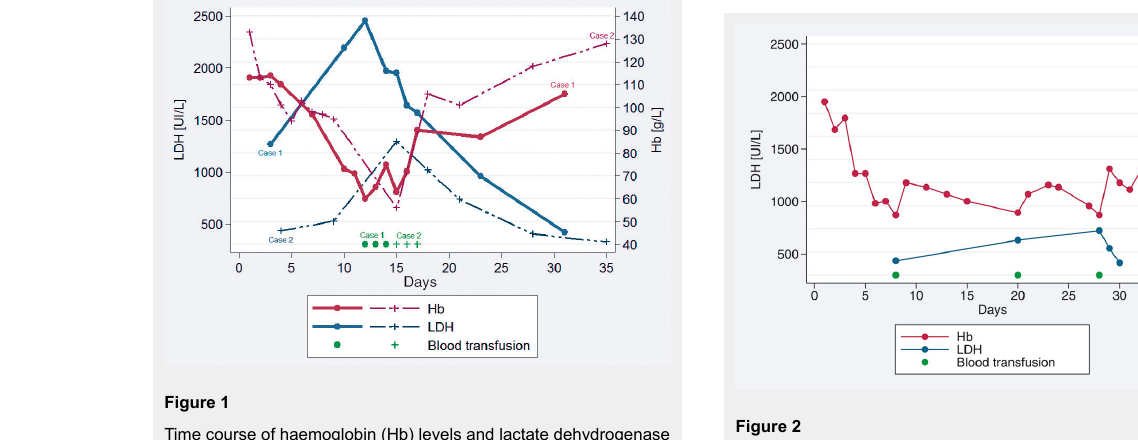
Time course of haemoglobin (Hb) levels and lactate dehydrogenase (LDH) levels in case 1 and case 2 (delayed pattern). N.B.: Because of the low number of LDH data, case 3 is not